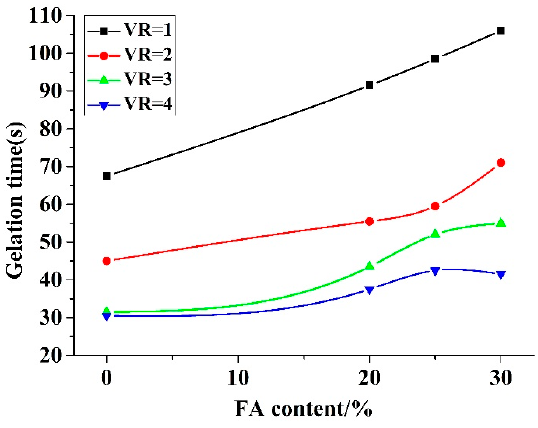
Figure 7. Test result of gelation time of the slurry (VR: the volume ratio).